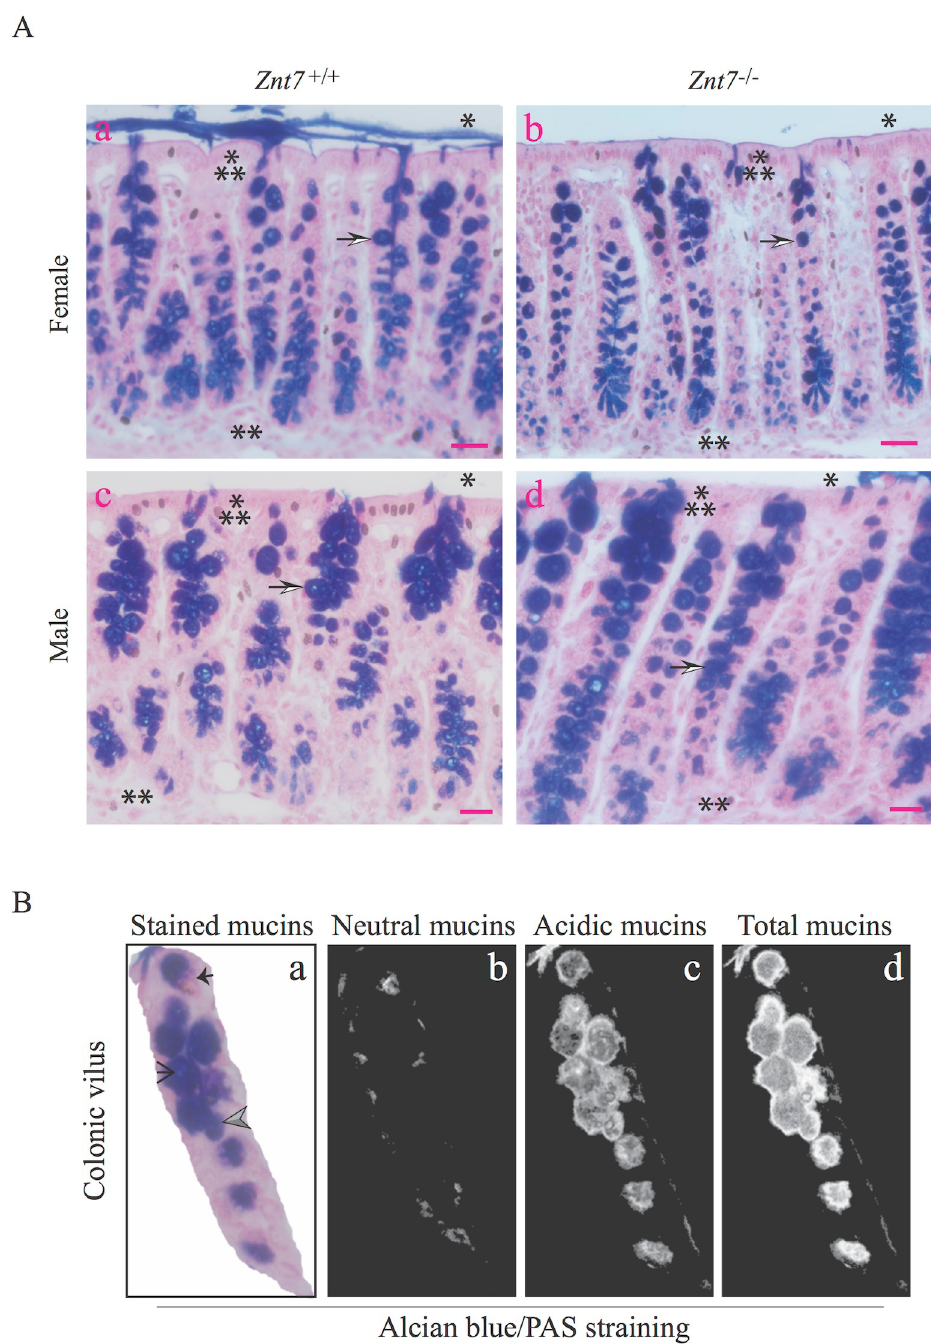
Fig 2. Mucin staining and quantification in the mouse colon. (A) Representative staining from the colon tissue (1 cm distal to the cecum) isolated from (a) female WT, (b) female Znt7 -/- , (c) male WT, and (d) male Znt7 -/- mice. The sections were stained with Alcian blue/PAS and counterstained with Nuclear Fast Red to visualize cell nuclei. Arrows indicate goblet cells. � indicates the lumen side of the colon and �� indicate the basal side of the colon. ⁂ indicates the epithelium of the villus. Scale bar = 25 μ m. (B) Representative images for automated quantification of color shades in the colonic villus using TissueQuant software. (a) An Alcian blue/PAS stained image. The solid and open arrows indicate neutral and acidic mucins stained magenta and bright blue, respectively. The gray arrow denotes the overlapping of neutral and acidic mucins (dark blue/purple). TissueQuant masking for (b) magenta color shade for neutral mucins, (c) blue color shade for acidic mucins, and (d) dark blue/purple color shade for both neutral and acidic mucins.